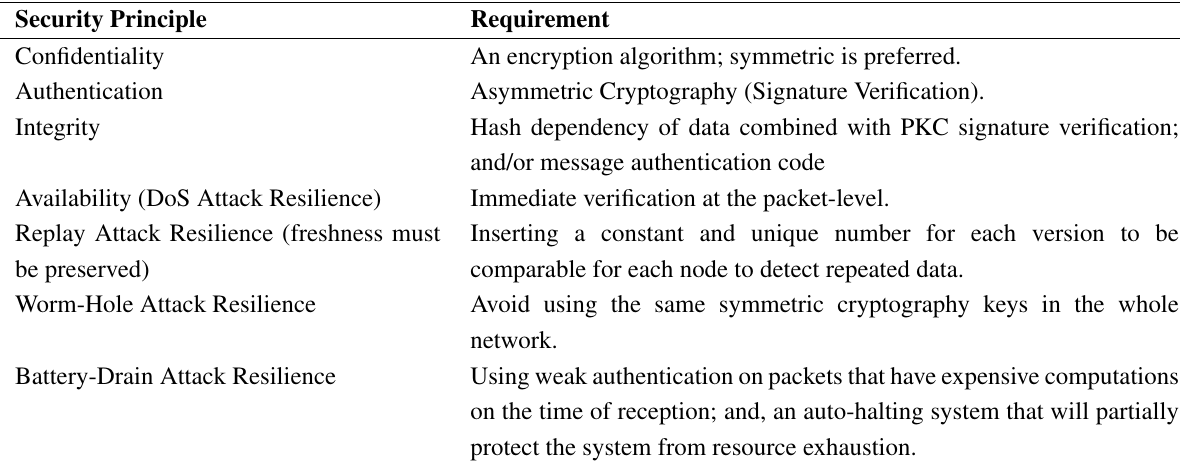
Table 2. Security Model Requirements (SMR).